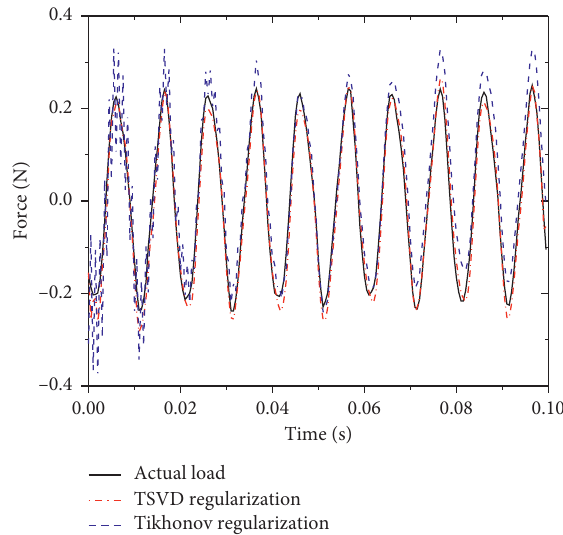
Figure 11: The identify results comparison based on different regularization methods.